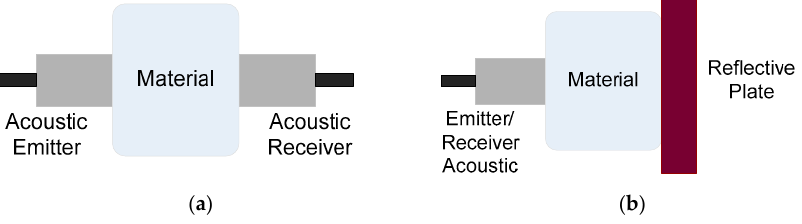
Figure 4. Heckmann´s piezoelectricity diagram [45].